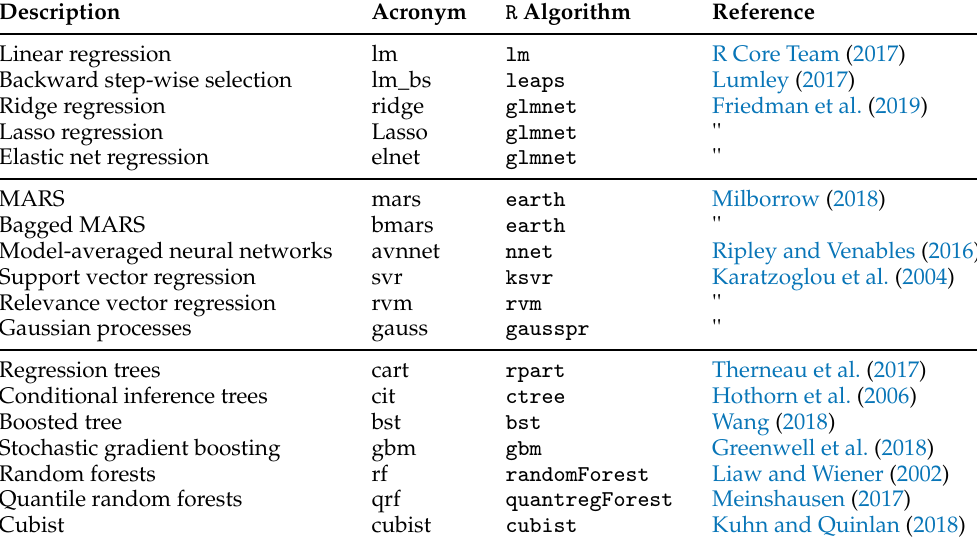
Table 1. List of first-level learners and corresponding R algorithms. The three blocks of table identify linear (top), nonlinear (middle) and rule-based (bottom) models. Note that we consider two versions of ridge and lasso: (i) the standard one involving the penalty term associated with the best-in-sample performance and (ii) that based on the one-standard-error rule of Hastie et al. (2009). Description Acronym R Algorithm Reference Linear regression lm lm R Core Team